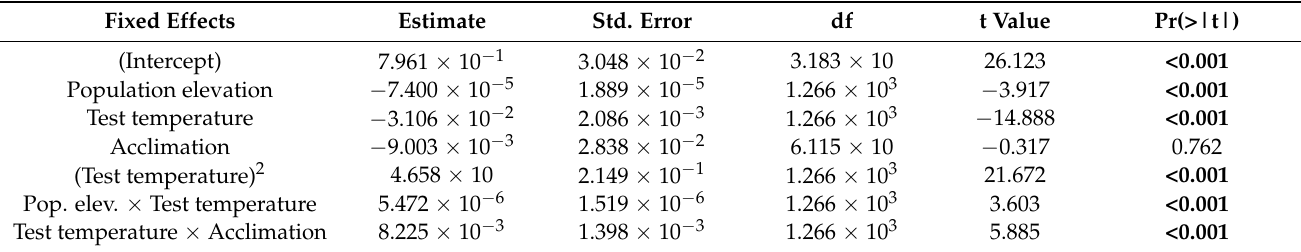
Figure 1. Interaction effects between test temperature (5, − 5, − 10, − 15, and − 20 ◦ C) and acclimation treatment on the damage index (%) of samples averaged across koa population elevations (from 603 m to 2050 m). Each box represents the mean ( ± SE, standard error) damage index (%). Black dashes inside the boxes represent the means. Table 3. Results of linear mixed-effects